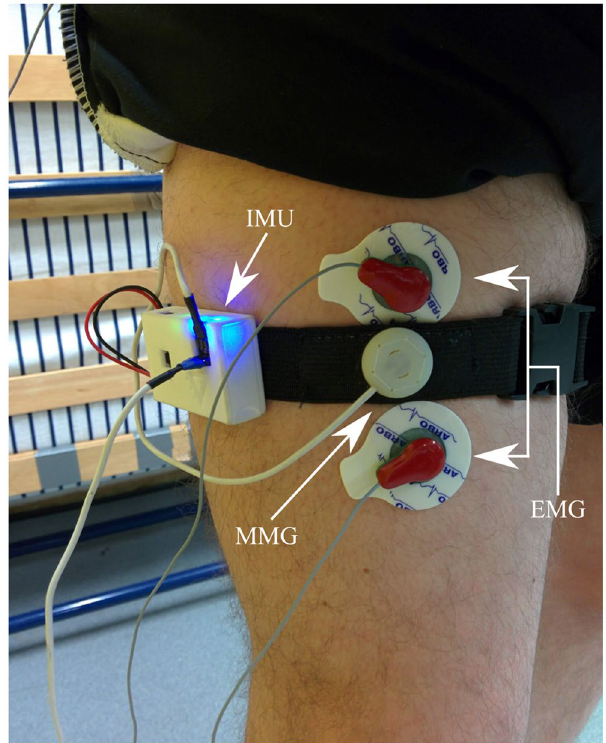
Figure 4. Sensor configuration for this study with MMG and EMG electrodes positioned over the rectus femoris muscle (quadriceps) 50% between the anterior spina iliaca superior and the superior part of the patella, and the IMU parallel to the line on the lateral side of the leg. The MMG sensor was sewn into the elastic strap and the Mylar membrane was resting upon the skin above the rectus